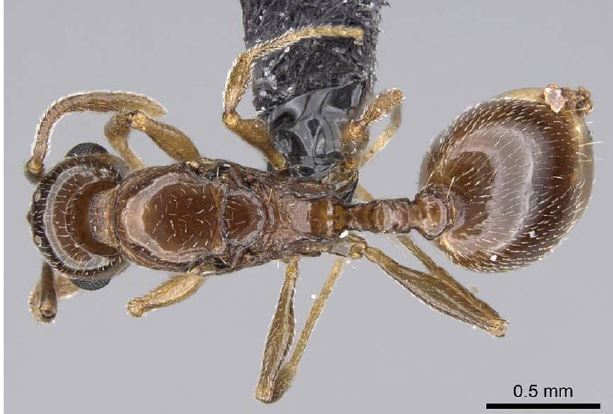
Fig 6 . Temnothorax ansei sp.n. queen in dorsal view. Photo